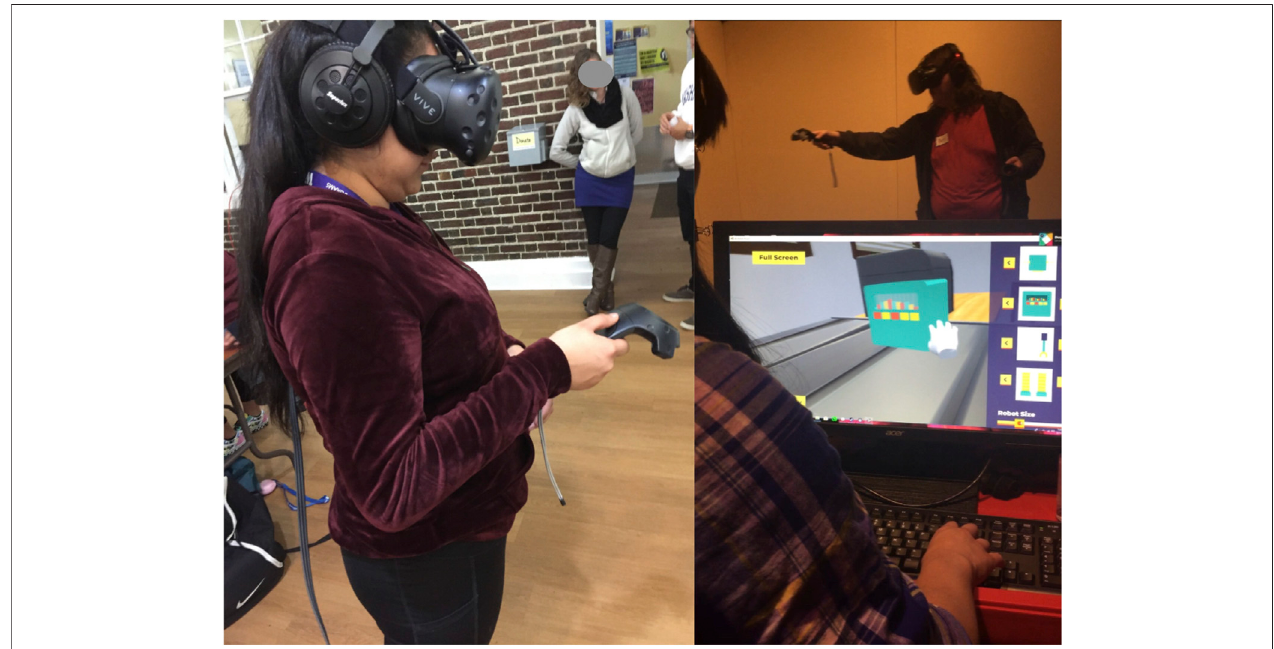
FIGURE 6 | Players during the usability testing: VR and Computer